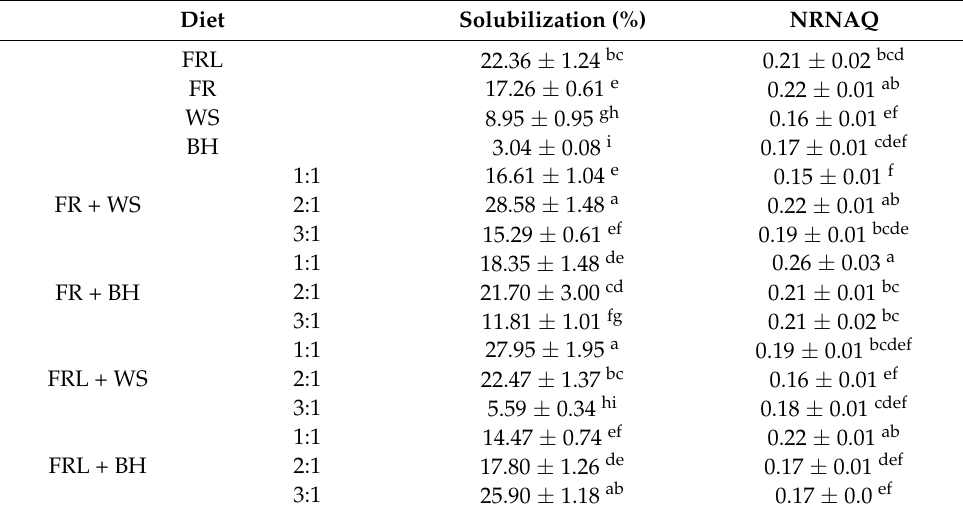
FR, Ficus racemosa ; FRL, F. religiosa ; WS, Wheat straw; BH, Berseem hay; NRNAQ, Nitrogen RNA Quotient. Values are indicated as mean ± sd, and values within the same column with different superscripts letters are significantly different ( p <